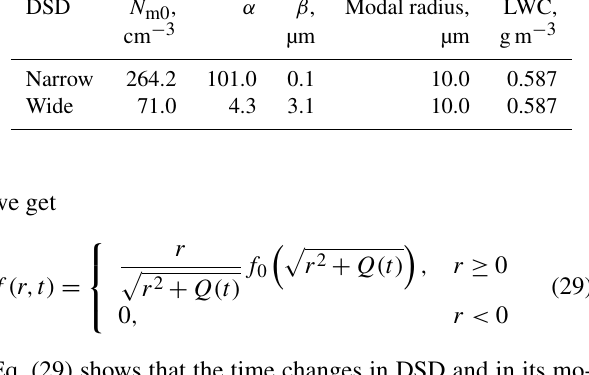
Table 3. Parameters of the initial Gamma distributions.